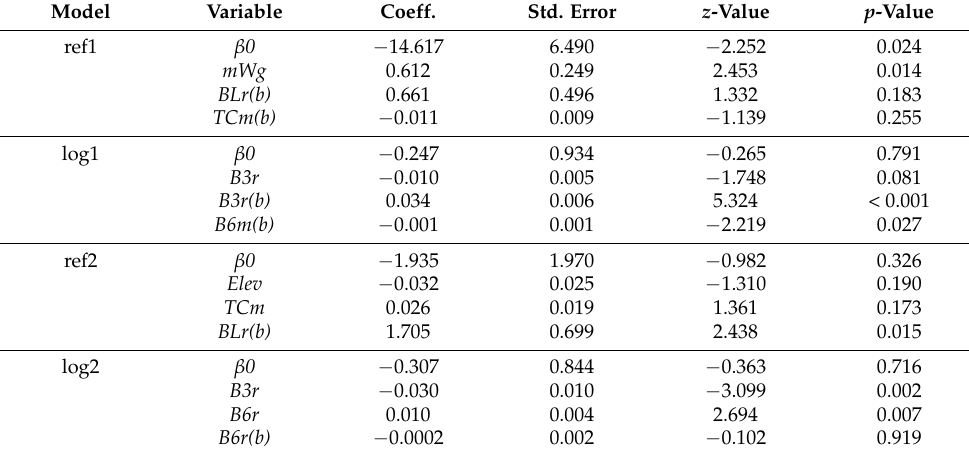
Table A1. Detailed description of the reference (ref1, ref2) and the best-ranked S2 variable-based (log1, log2) logistic regression fits, including regression coefficients, their standard errors, z -, and p -values associated with each predictor. Regressions ref1 and log1 refer to disturbance occurrence (NDG vs. DG0-1), while ref2 and log2 refer to binary disturbance severity (DG0 vs. DG1); β 0 refers to the constant term of the regression